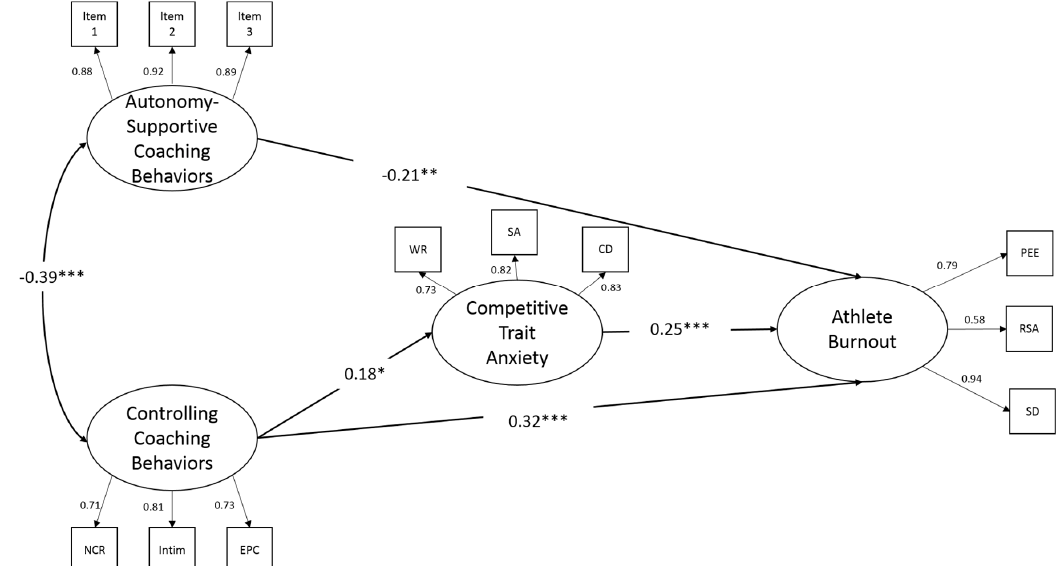
Figure 1. Structural equation model with standardized estimates in the relations between perceived coaching behaviors, competitive trait anxiety, and athlete burnout. Only significant pats are presented.